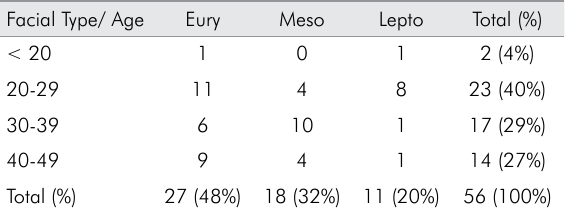
Table. Representation of ages ranging from 18 to 49 years, and euryprosopic (eury), mesoprosopic (meso) and leptoprosopic (lepto) facial types. Mean of 32.6 years, SD = 8.8